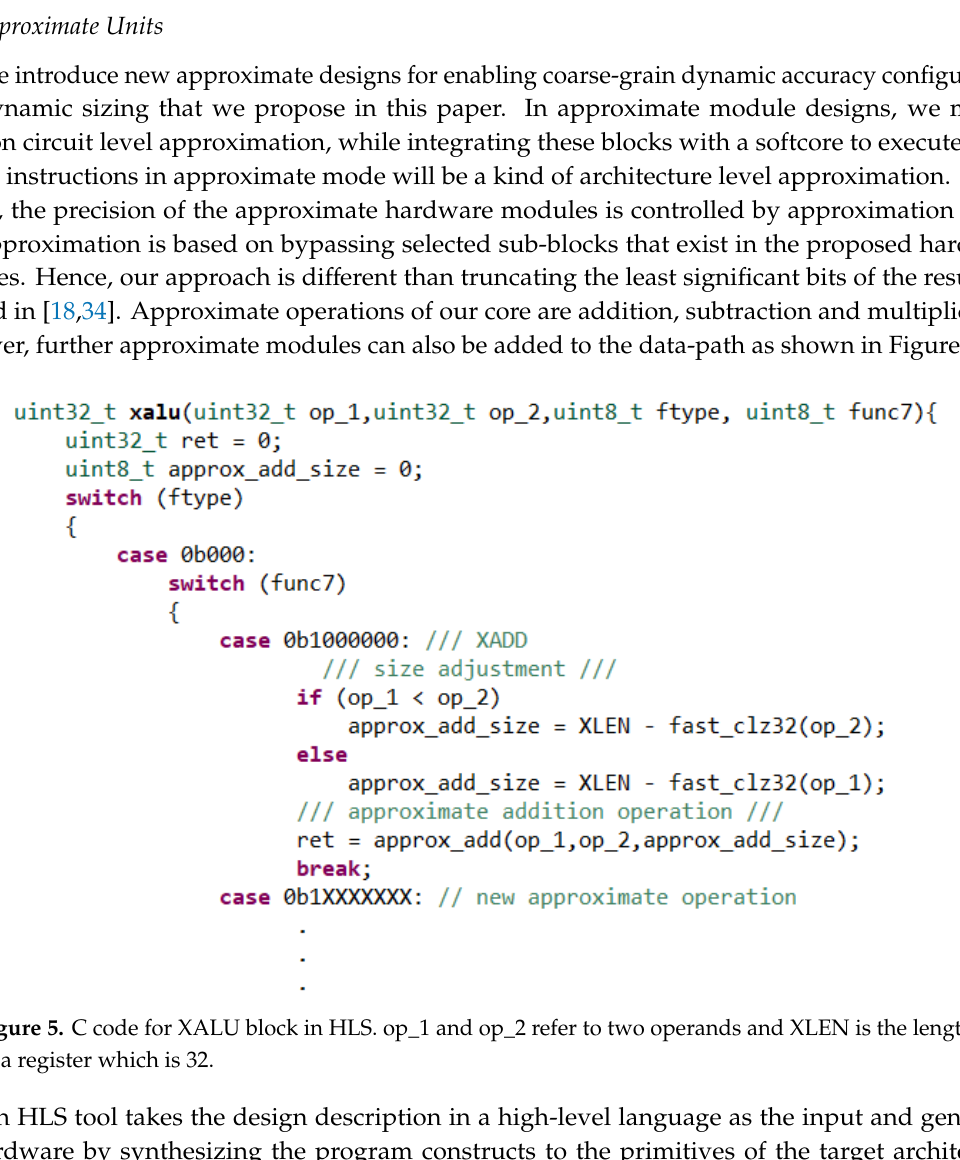
Figure 4. R-type RISC-V instruction structure and modification for approximate ( XADD, XSUB and XMUL) operations.